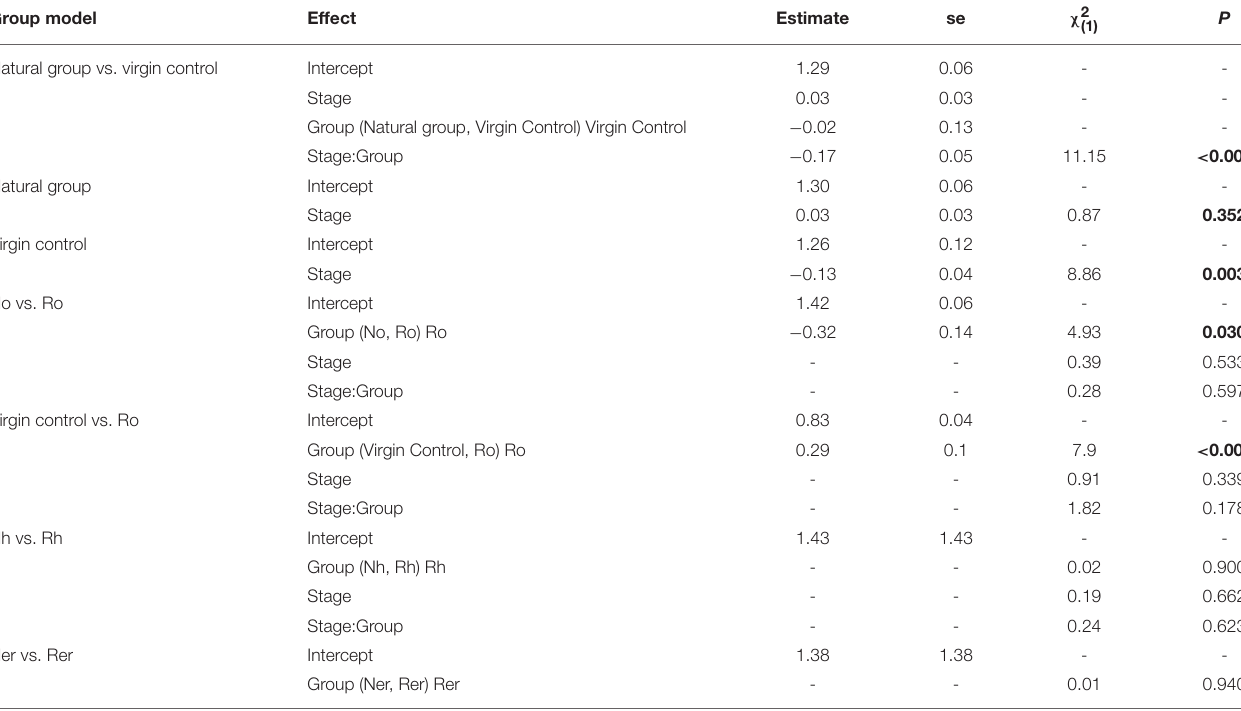
TABLE 1 | Statistical analyses of SMR in mothers of the natural and removal groups and virgin control females in the subsocial S. lineatus . Group